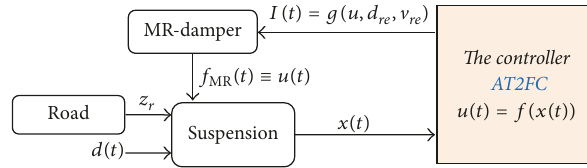
Figure 4: The MR-damper used as an actuator for the control strat- egy of the proposed active suspension controller AT2FC ( 𝑑 𝑟𝑒 (𝑡) = 𝑥 (𝑡) − 𝑥 (𝑡); V (𝑡) = 𝑥 (𝑡) − 𝑥 (𝑡) ). 1 3 𝑟𝑒 2 4